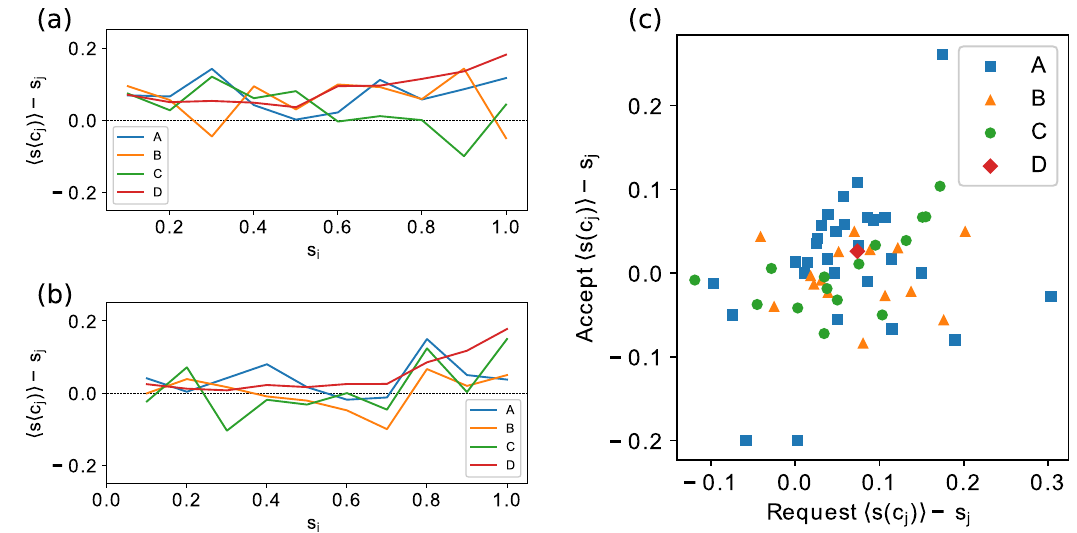
Figure 5. Requesting ( a ) and accepting ( b ) strategies in the experimental setups by cluster size. The values are averages of the human interactions in terms of sent requests and accepted requests, where each value is the difference between the normalized average cluster size of the neighbours sharing the chosen neighbour’s colour ( (cid:31) s ( c j ) (cid:30) ) and the normalized cluster size of the chosen neighbour ( s j ). Positive values indicate more cooperative decision making in terms of choosing the neighbour with the lowest cluster size of that particular colour and negative values indicate the opposite. If the decision making was completely random, the value would be 0. ( c ) Individual average strategies in the games. Each marker represents a player in a particular setup. The autonomous agents are represented by the average value for all uniformly constructed agents in setup D. Negative values indicate that the player’s strategy on average was not to request the most beneficial neighbour, or accept requests from the neighbour with the smallest cluster